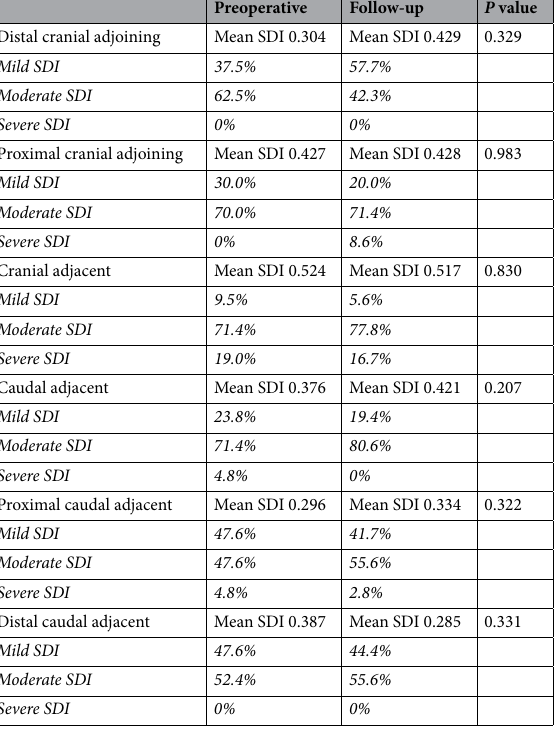
Table 6. Comparison of